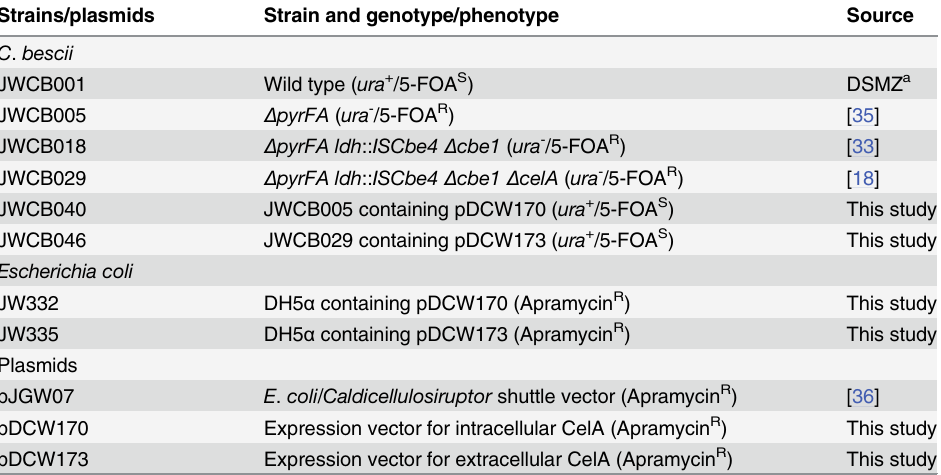
Table 1. Strains and plasmids used in this work.